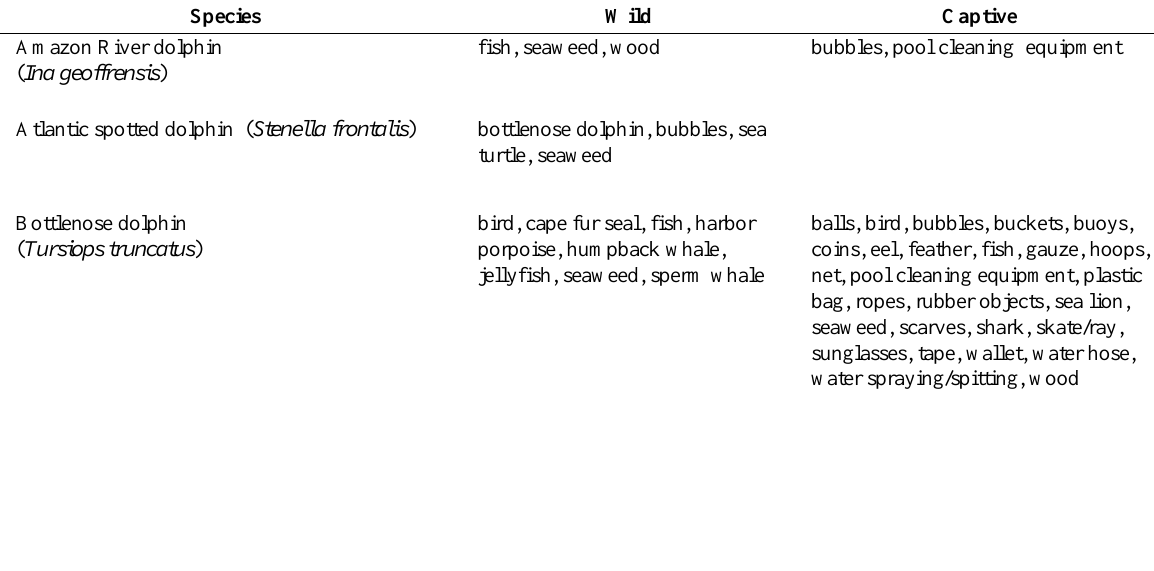
Examples of Objects used in Play by Various Species in Captivity and in the Wild Species Wild